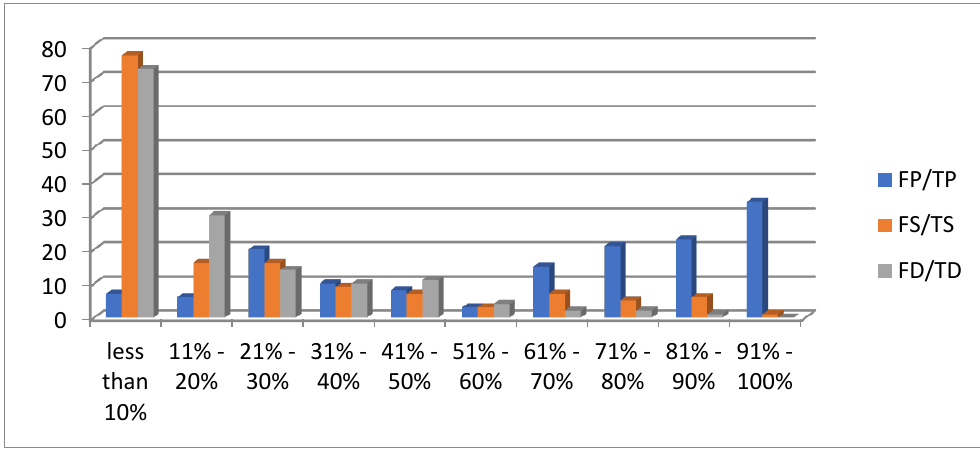
Figure 1. The distribution of the Kuwaiti firms based on their foreign environment.